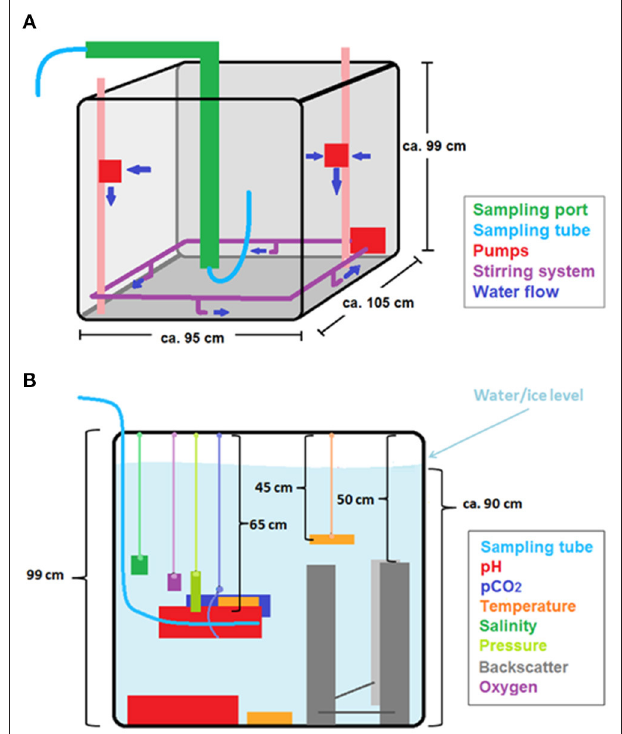
FIGURE 1 | Schematic illustration of the experimental tank with its stirring and sampling systems (A) and all sensors discussed in this manuscript (B) .